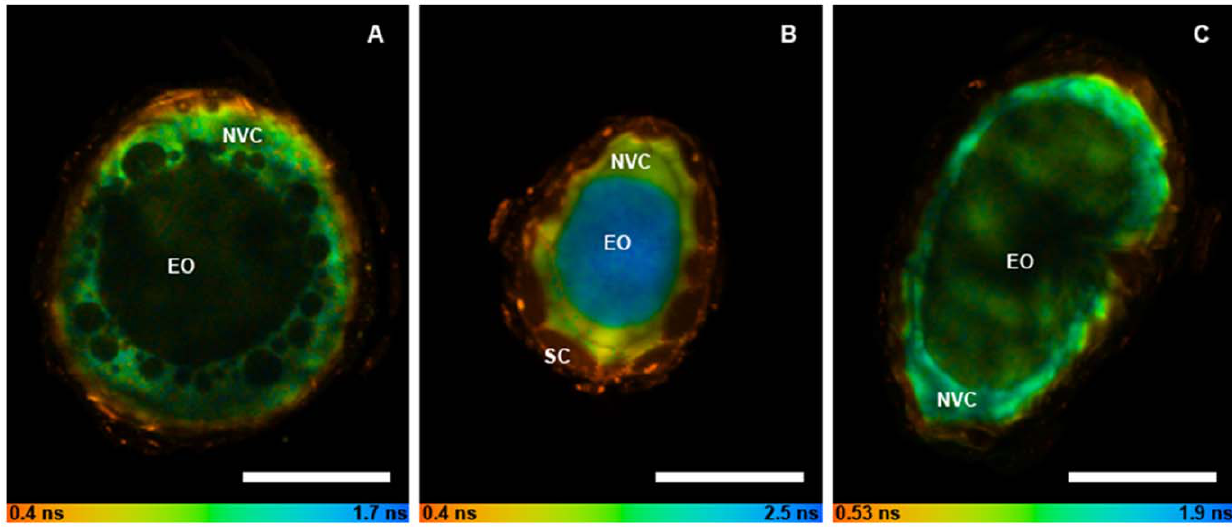
Figure 4. Fluorescence lifetime images of enzymatically isolated eucalypt secretory cavities showing localization of the lumen non- volatile component. Eucalypt species: E. polybractea (A), E. froggattii (B) and E. spathulata (C). Pseudocolour mapping represents mean fluorescence lifetime. Secretory cells (SC); non-volatile component (NVC); essential oil (EO). Scale bar represents 50 m m.